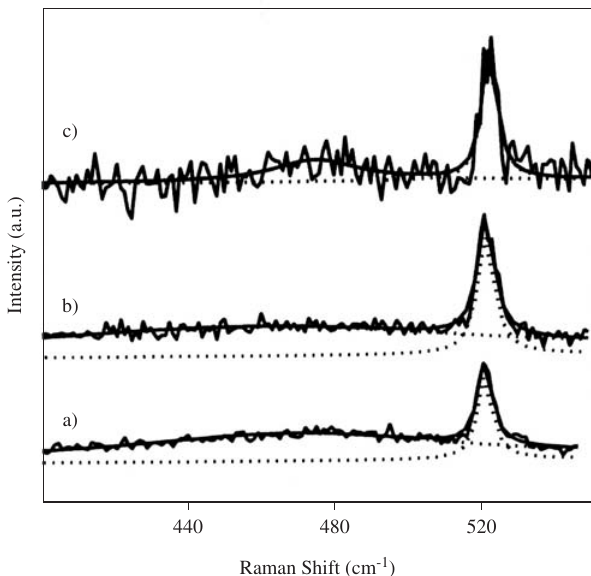
Figure 5. Raman spectra of silicon sample machined in ductile regime for exciting lines: a) 488.0 nm; b) 457.9 nm; and c) 514.5 nm wavelengths.